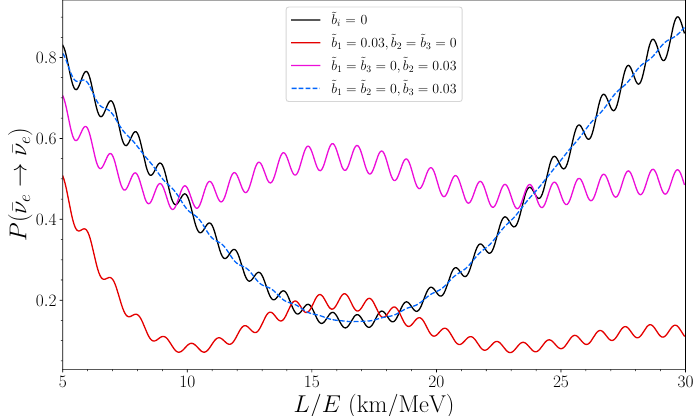
Figure 6. Plots of the anti-electron neutrino survival probability as a function of L/E for the 3-flavour top-hat density of states set up as defined in section 2.5 for the case where only one of the three states has a finite breadth, of fractional value ˜ b = 0 . 03 and the remaining two are δ -functions. Also shown for comparison is the probability distribution for the standard scenario in which the density of states comprises of 3 δ -functions ( b i = 0